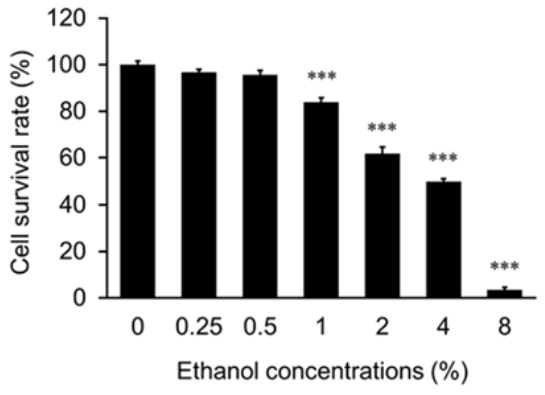
Figure 1. Measurement of cell viability of HepG2 following ethanol treatment. The cell survival rate was measured by the trypan blue method following treatment of HepG2 cells with different concentrations of ethanol. The data represent the mean ± SEM ( n = 3). Asterisks indicate significant difference analyzed with Dunnett’s test. *** p < 0.001 vs. 0% ethanol as a control.